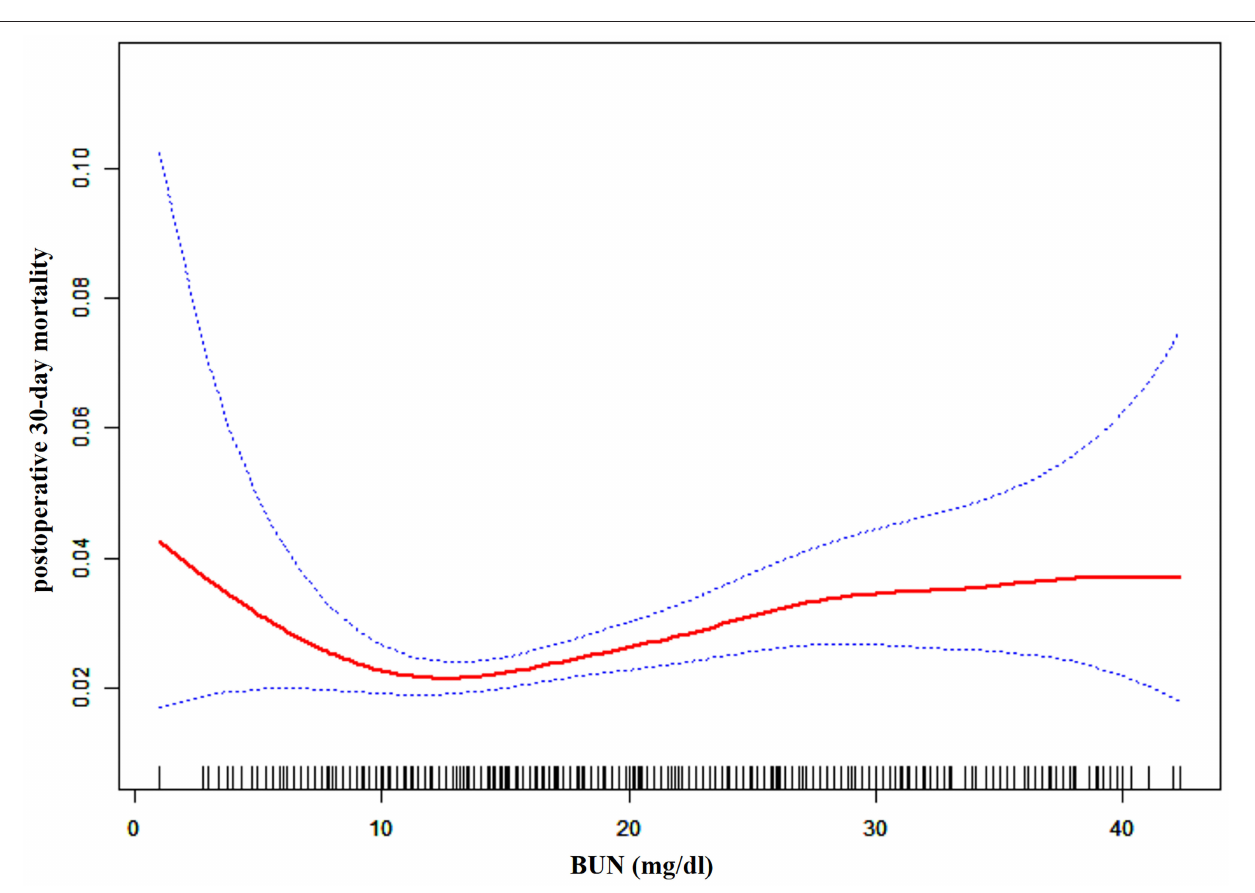
sizes and CIs to the left and right of the inflection point with the piecewise binary logistic regression model. On the left side of the inflection point, the effect size was 0.832, and the 95% CI was from 0.737 to 0.941. On the right side of the inflection point, the effect size was 1.028, and the 95% CI was from 1.011 to 1.045 ( Table 3